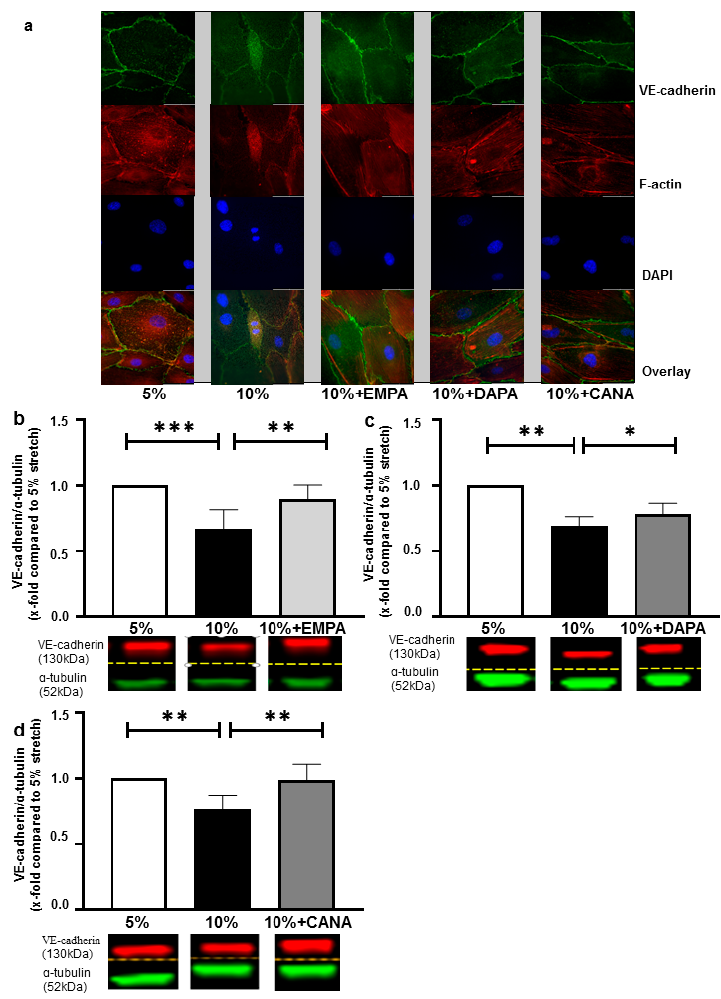
Figure 2. SGLT-2i’s restore VE-cadherin loss of HCAECs exposed to 10% stretch. Cells were treated with 5% stretch plus vehicle, 10% stretch plus either vehicle or one of the SGLT-2i’s (1 µM EMPA, 1 µM DAPA and 3 µM CANA). VE-cadherin and F-actin were stained after 24 h, and representative images of staining are presented ( a ) n = 3. VE-cadherin levels were quantified with western blot for EMPA treatment ( b ) n = 6, DAPA treatment ( c ) n = 6 and CANA treatment ( d ) n = 6. Representative bands of VE-cadherin and α -tubulin (internal reference) are shown in the lower panels of each bar graph ( b – d ) and data are presented as mean ± SD. * p < 0.05 vs. 10% stretch, ** p < 0.01 vs. 10% stretch, *** p < 0.001 vs. 10% stretch. Whole (uncropped) western blots can be found as supplemental information).